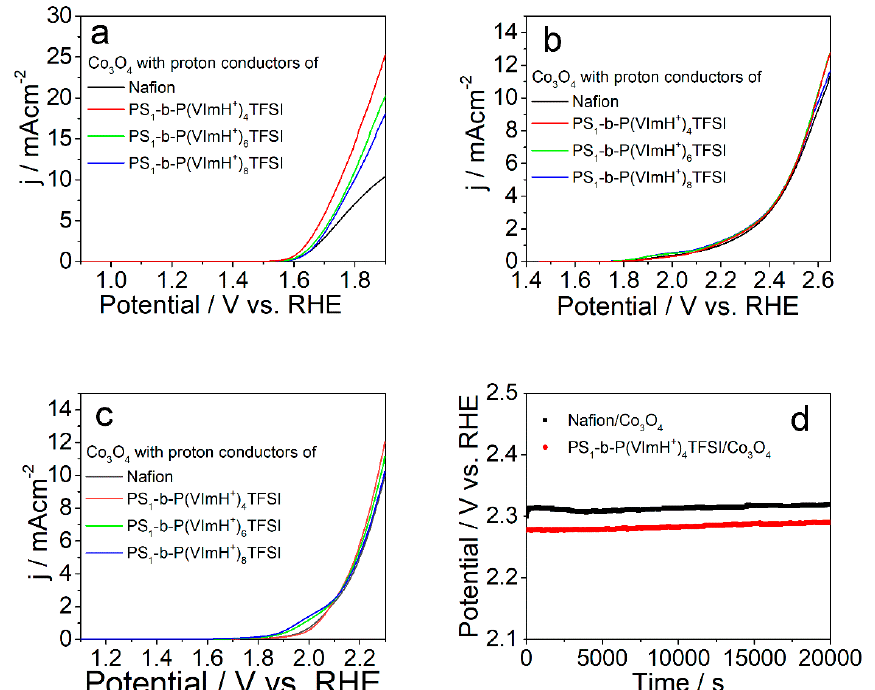
Figure 5. LSV curves of Co 3 O 4 catalyst using di ff erent ion conductors as indicated in the figures with a sweep rate of 5 mVs − 1 in ( a ) 1.0 M KOH, ( b ) phosphate bu ff er saline (PBS) bu ff er, and ( c ) 1.0 M HClO 4 . ( d ) Chronopotentiometric analysis of the catalyst stability for mixed Co 3 O 4 catalyst with Nafion ® and PS 1 -b-P(VImH + ) 4 TFSI at 10 mAcm − 2 in 0.1 M HClO 4 solutions.